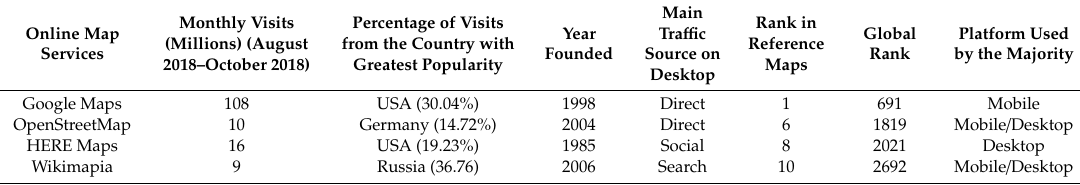
Table 1. Website tra ffi c data for online map services (Similarweb—last visited November 2018). Online Map